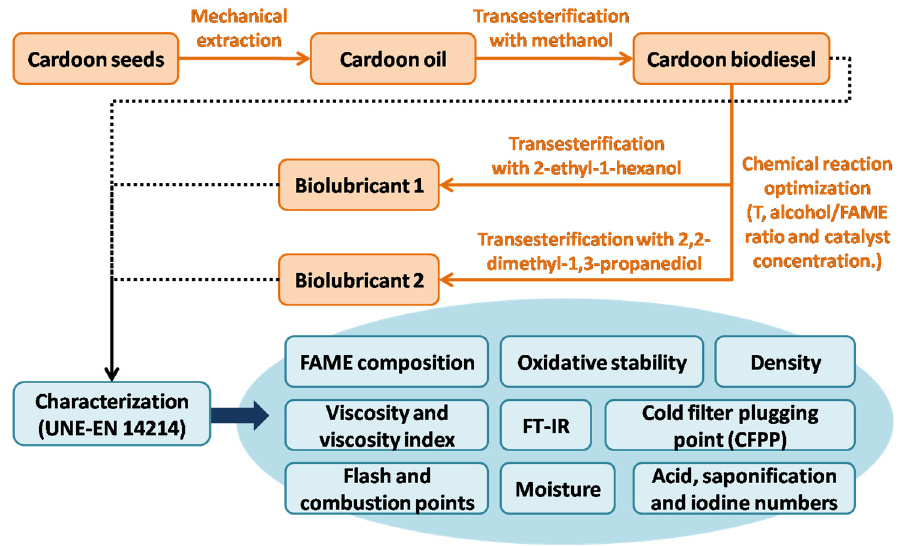
Figure 3. Experimental design.